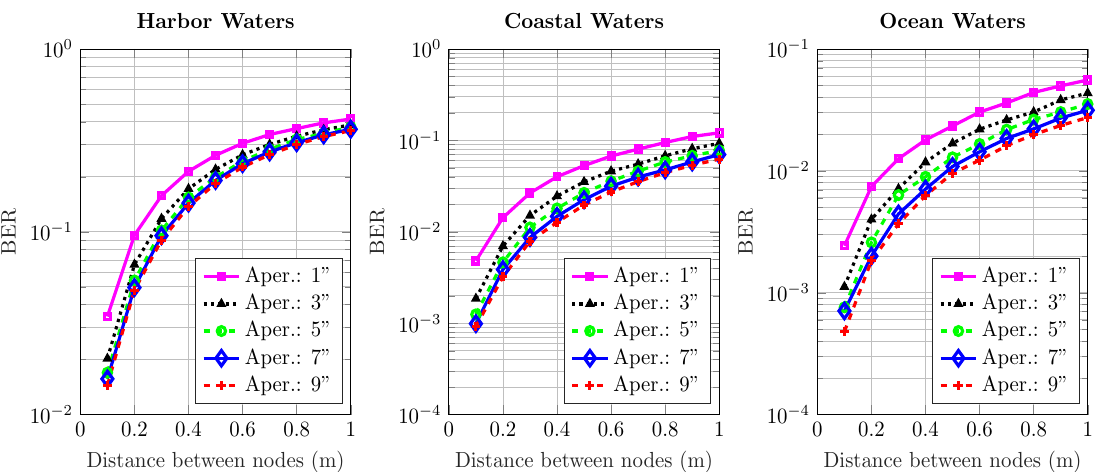
Figure 10. Effect of increasing transmission distance and aperture on the BER performance of harbor, ocean, and coastal waters for 180 ◦ receiver FoV.